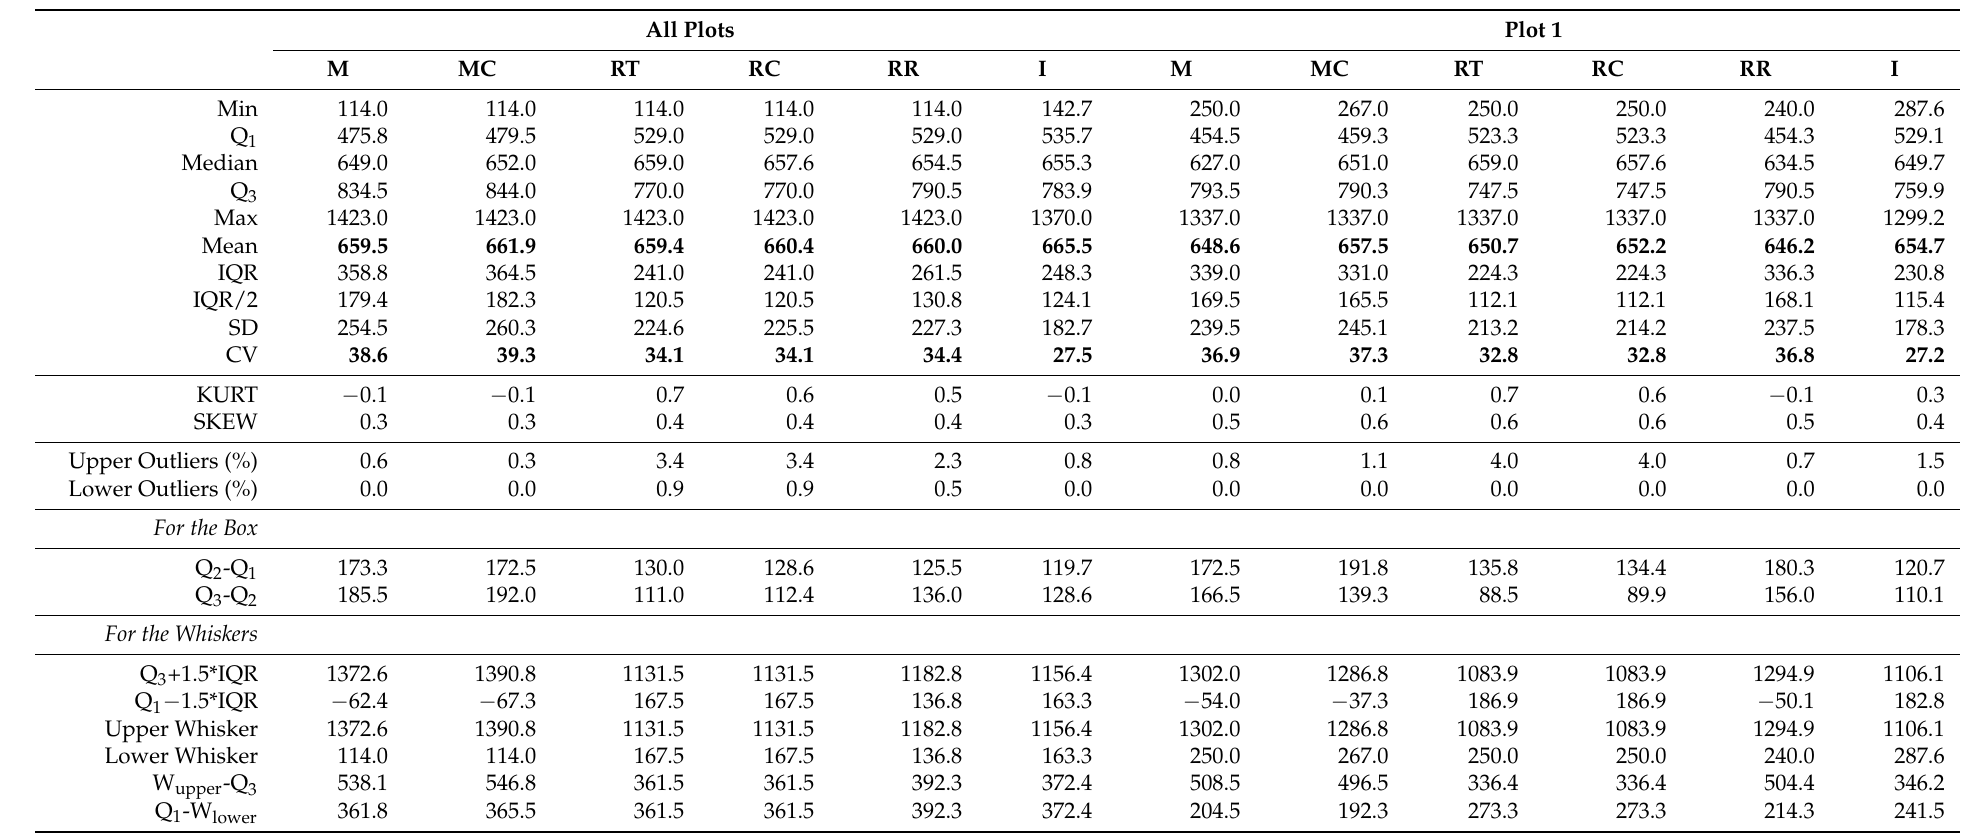
Table 1. Descriptive statistics for fresh weight (FW)